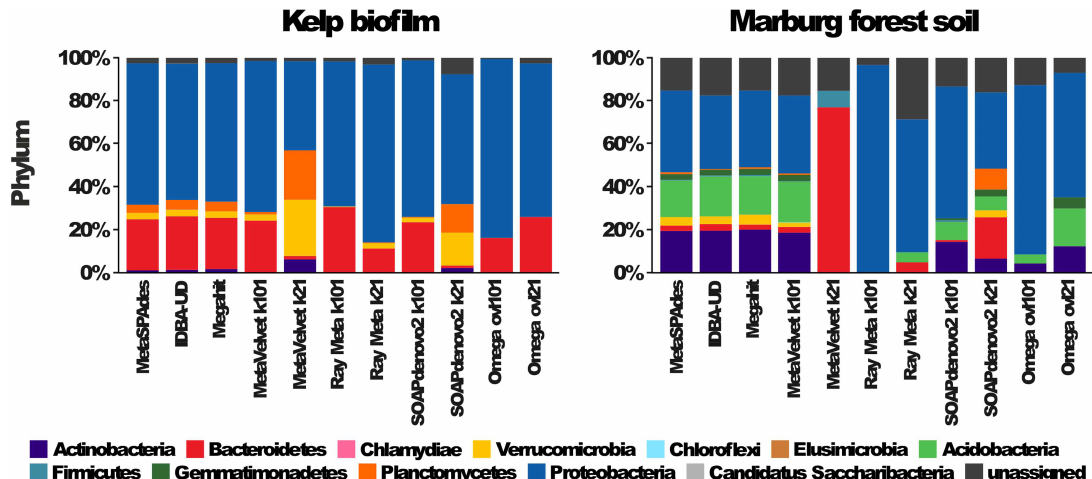
Fig 8. Differencesin phylogenetic profiles based on different assemblies of Kelp Biofilm (KBF) and Marburg forest soil (MFS) samples. Phylogenetic profilesare based on 40 single copy marker gene products identifiedwith fetchMG (www. bork.embl.de/software/mOTU/fetchMG.html) and annotations basedon alignments againstthe NCBI-nr databaseand the least common ancestor (LCA) method implemented by MEGAN5 [69]. The phylogeneticprofiles show the numberof marker gene products assignedto different taxa on phylum level. Additionalprofiles showingthe class and order levels are given in S2 Fig.